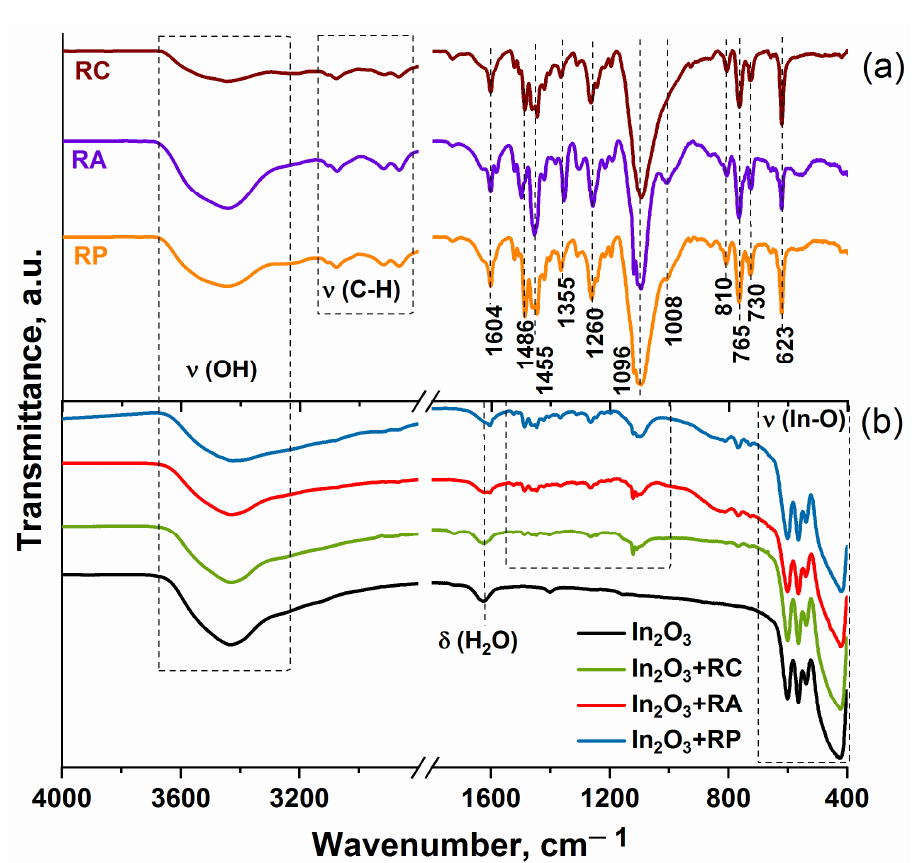
Figure 2. FTIR spectra of heterobimetallic Ru(II) complexes ( a ), pure In 2 O 3 , and hybrid materials ( b ). Figure 2b represents the FTIR spectra of the pure indium oxide and hybrid Table 2. Assignment of FTIR spectra vibrational modes [34–37].